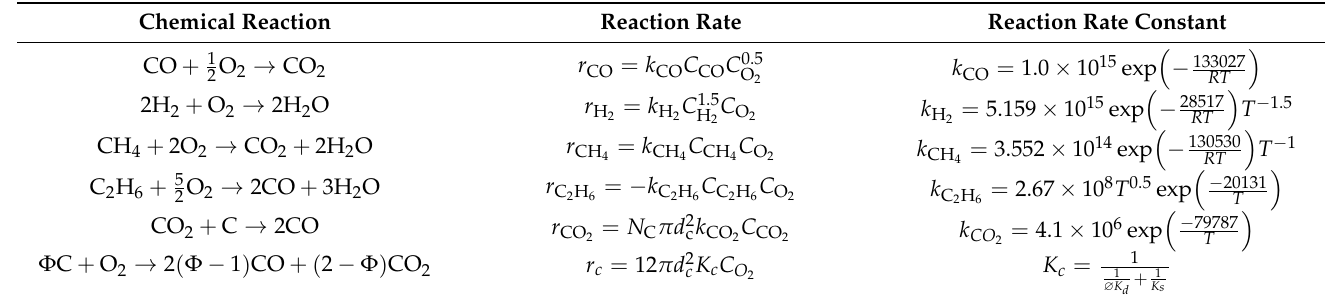
Table 1. Combustion reaction and kinetics